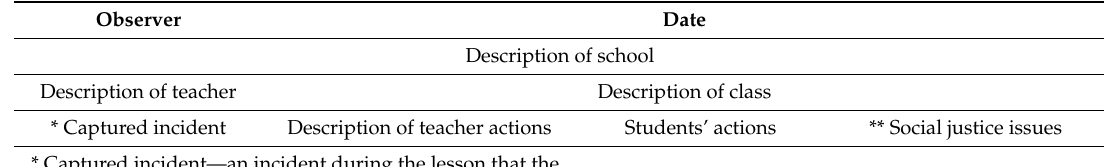
Table 2. Observational